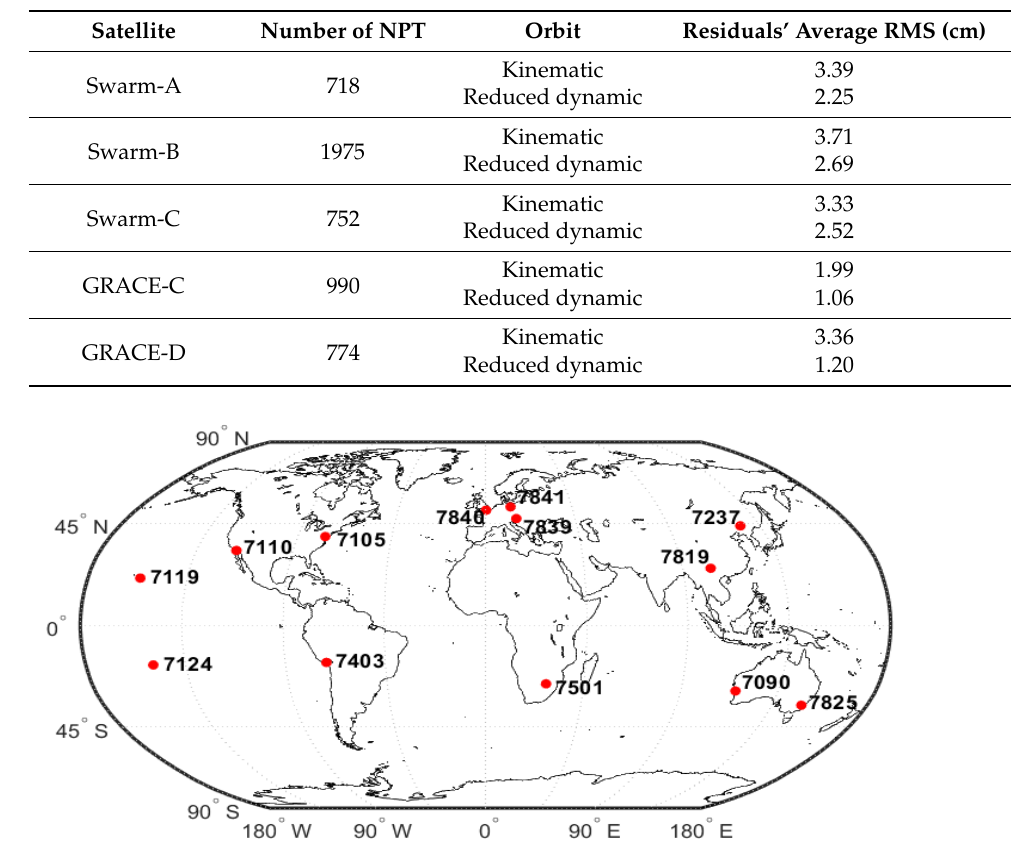
Table 4. Summary for SLR residuals.